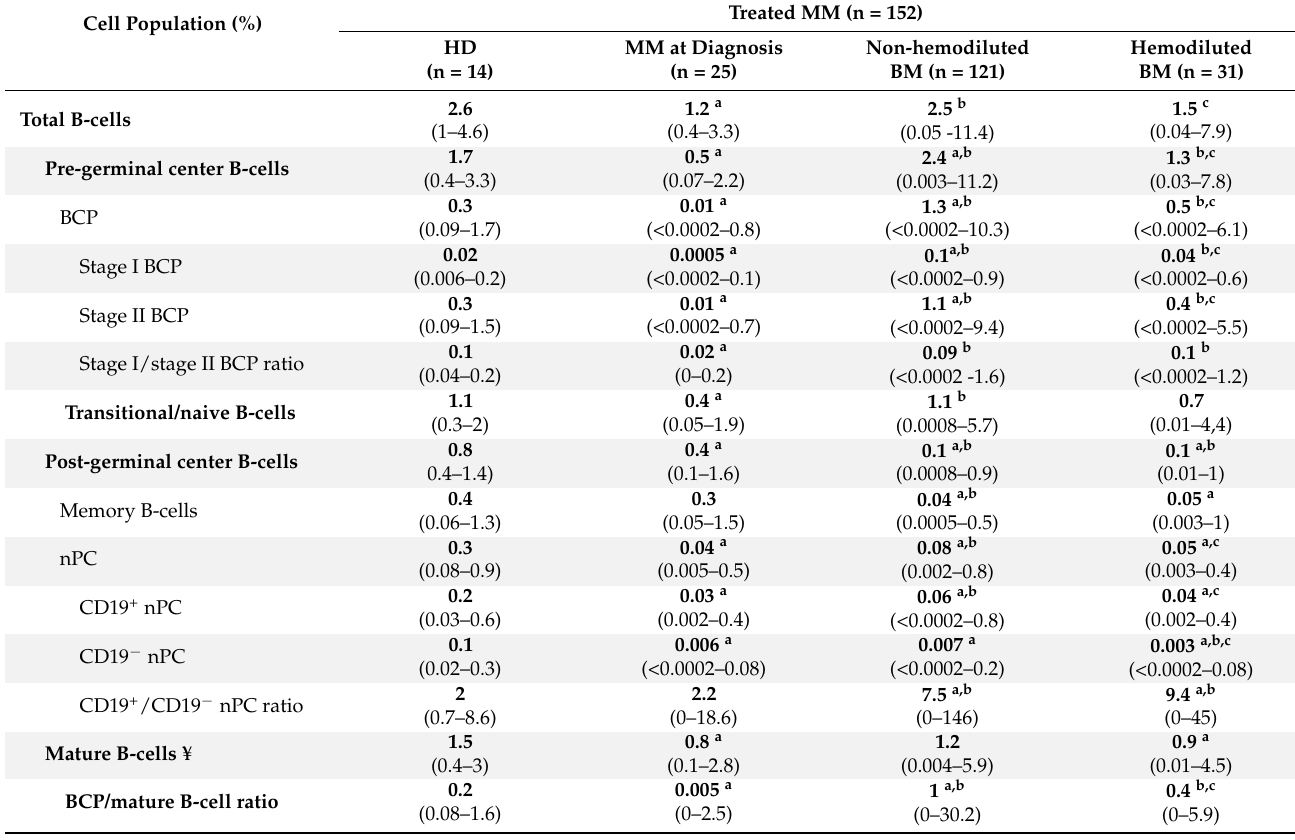
Table 1. Distribution of maturation-associated B-cell and normal plasma cell (nPC) populations in non-hemodiluted vs. hemodiluted bone marrow (BM) from treated multiple myeloma (MM) patients (vs. healthy donor (HD) and diagnostic patient